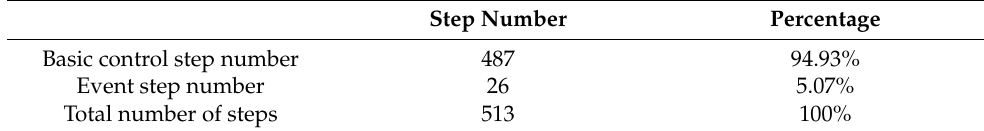
Table 2. Event trigger times in